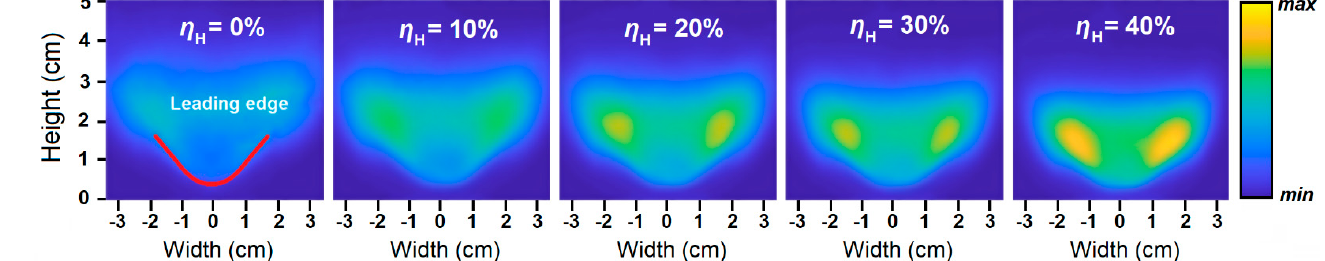
Figure 28. The relationship between the flame length and the hydrogen volume fraction [60].